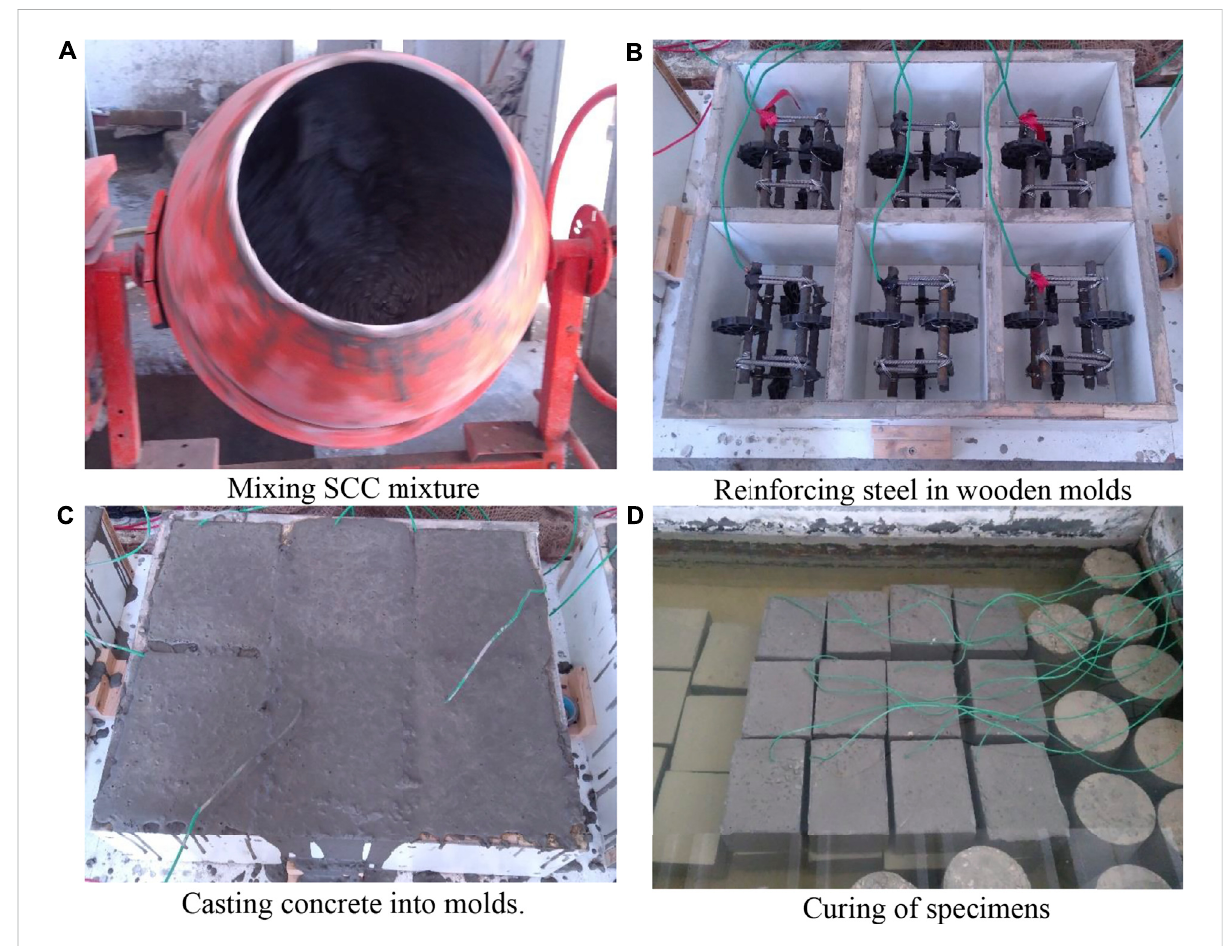
FIGURE 2 Mixing, casting and curing of concrete specimens. (A) Mixing SCC mixture. (B) Reinforcing steel in wooden molds. (C) Casting concrete into molds. (D) Curing of